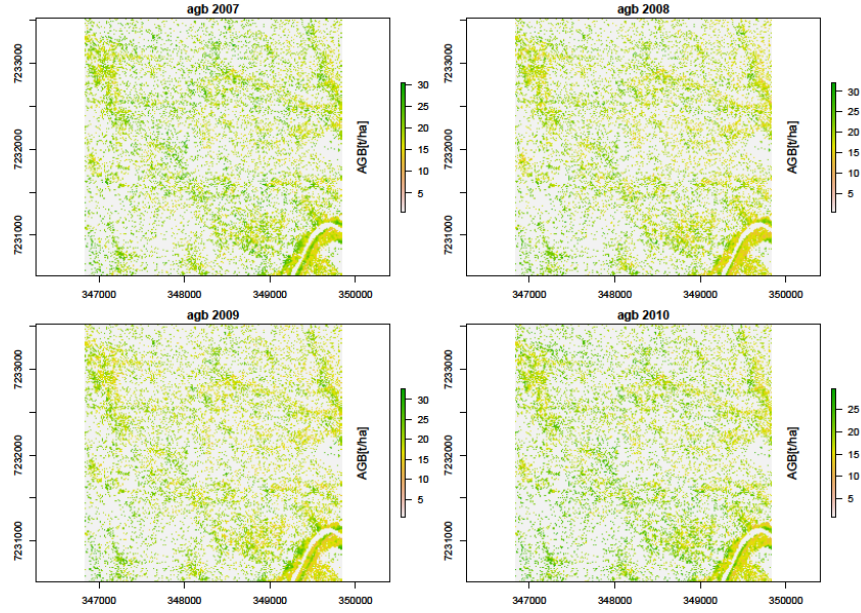
Figure 13. Predicted woody biomass from SAR backscatter intensity (HH + HV) for the years 2007, 2008, 2009, and 2010.